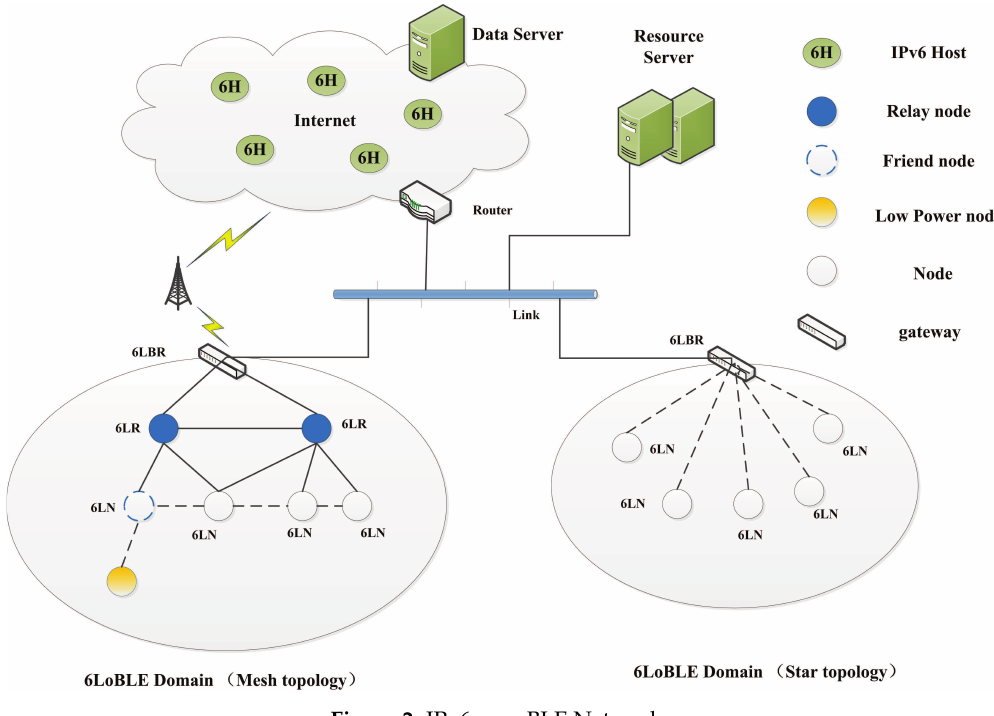
Figure 2. IPv6 over BLE Networks. Table 1. The nodes in IPv6 over Low Power Wireless Personal Area Network (6LoWPAN) and IPv6 over BLE